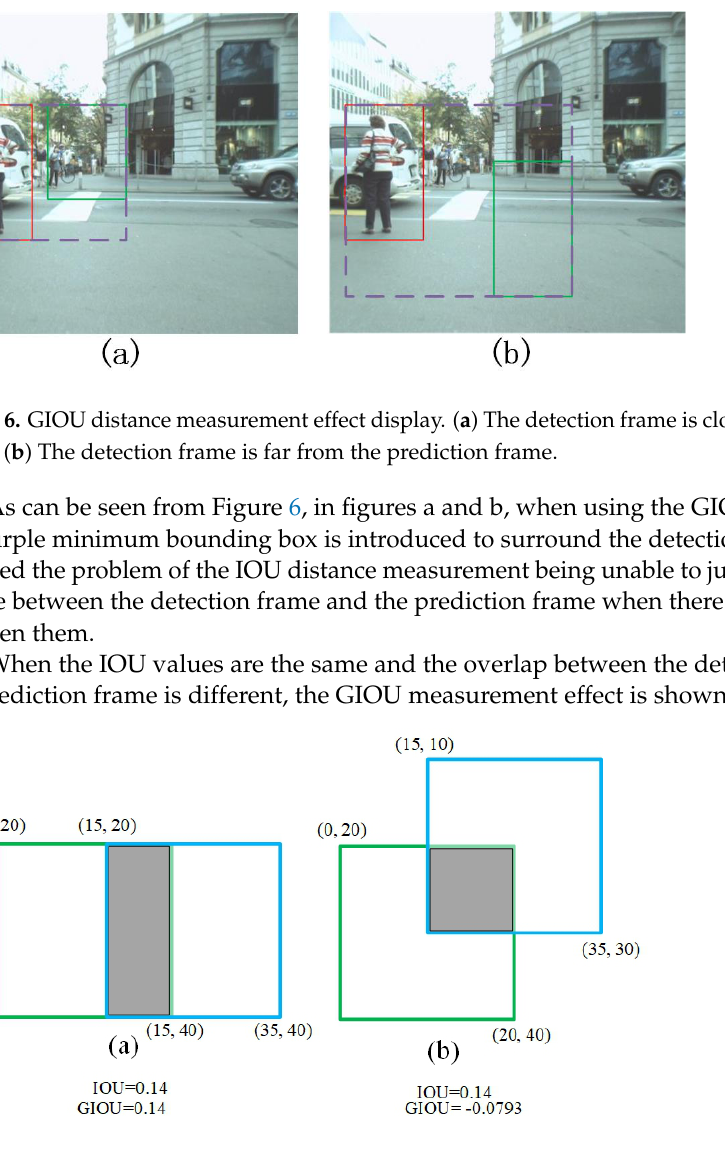
Figure 7. Effect drawing of GIOU measurement in different overlapping modes. ( a ) Horizontal overlap. ( b ) Cross